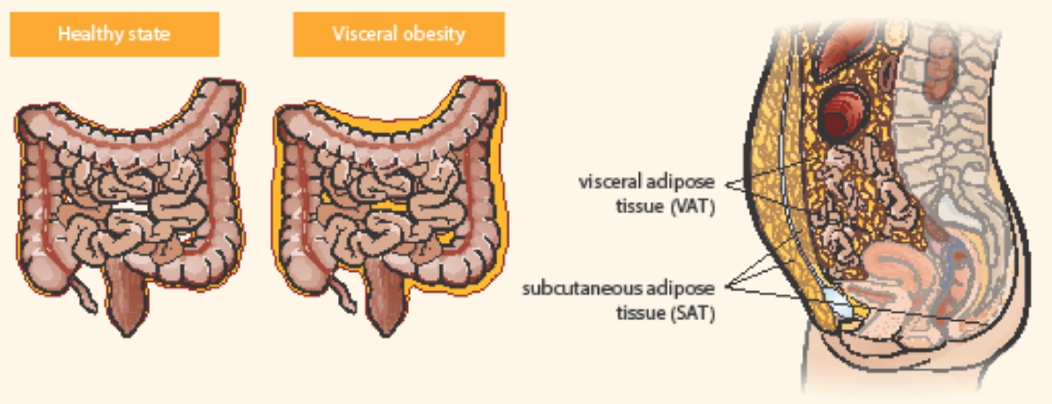
Figure 1. Distribution of abdominal adipose tissue in healthy state and visceral obesity. Adapted from Eder et al. [27].